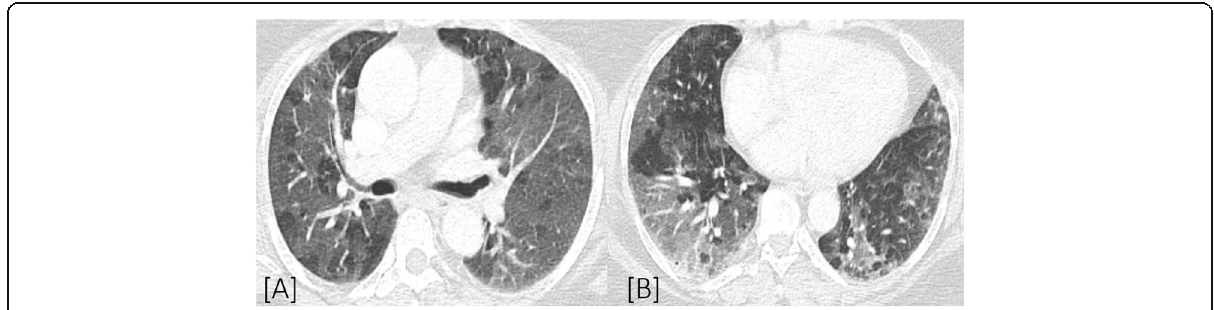
Fig. 6 A 52-year-old patient with active hepatitis, normal PFT complaining from progressive dyspnea. a , b Axial HRCT chest (lung window) showing bilateral patchy areas of air trapping mixed with GGO “ head cheese pattern ” without appreciable reticular changes. Sub-acute